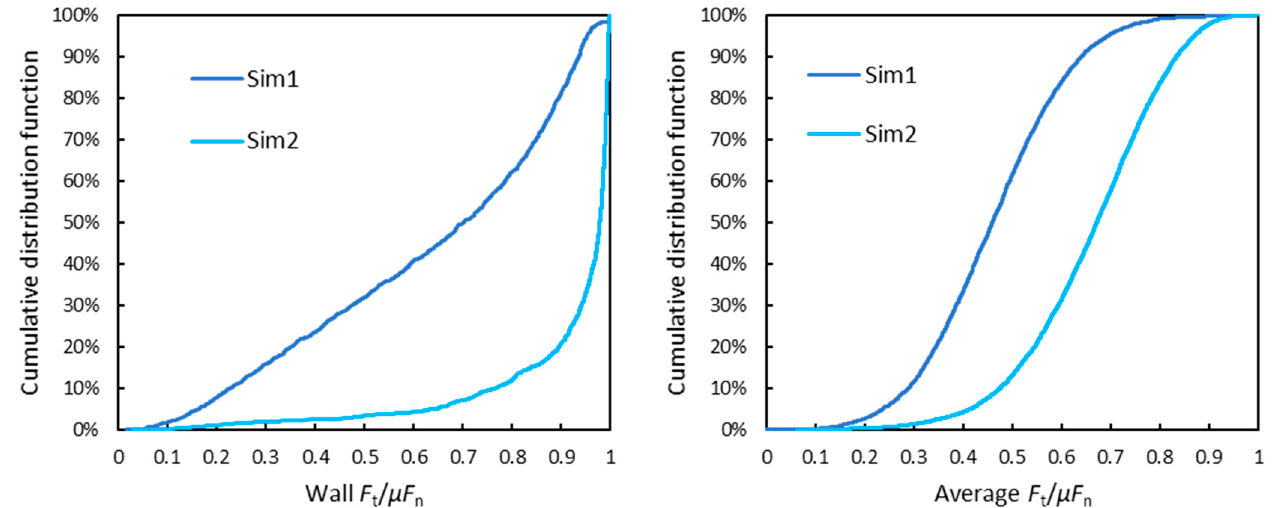
Figure 6. Cumulative distribution of the ratio between the tangent force and its maximum value for particle-wall contacts ( left ) and all contacts ( right ).